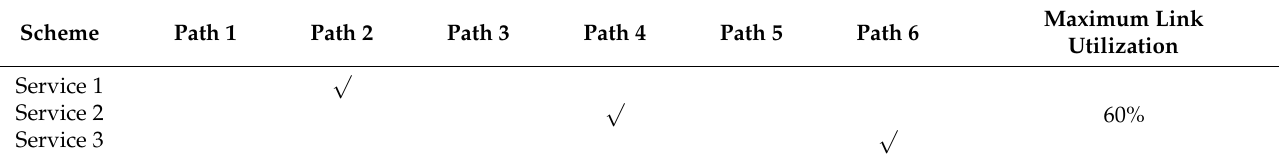
Table 3. Status of service deployment before optimization.